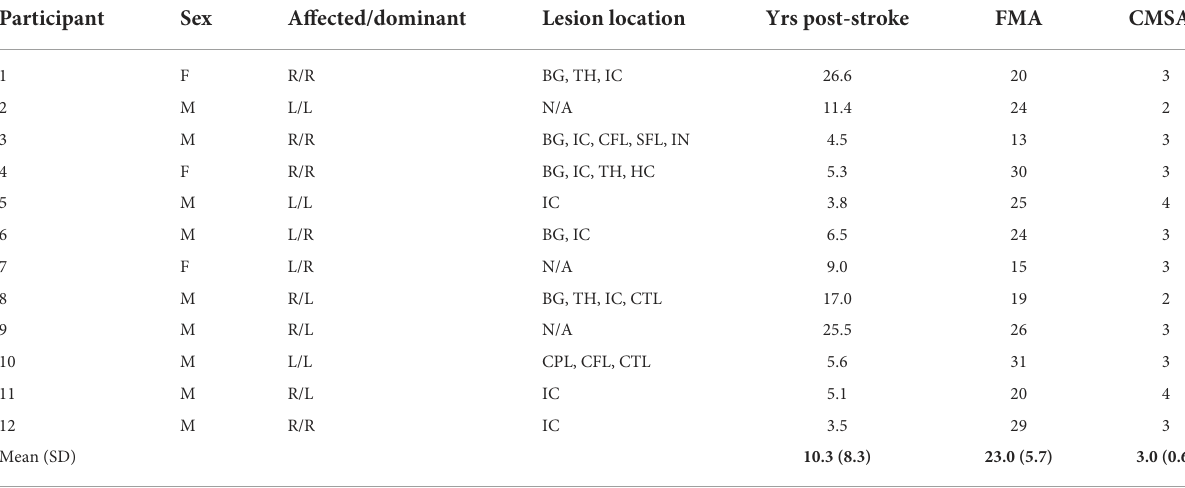
TABLE 1 Demographics of the participants with chronic hemiparetic stroke.